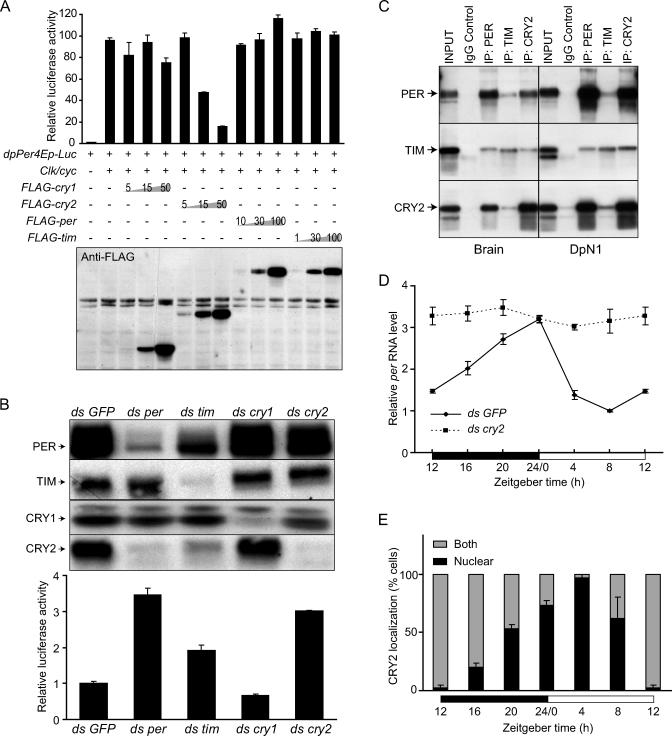
CRY2 Is a Major Repressor of CLK:CYC–Mediated Transcription in DpN1 Cells(A) Monarch CRY2 inhibits dpCLK:dpCYC–mediated transcription using luciferase reporter gene assays. The monarch butterfly per E box enhancer luciferase reporter (dpPer4Ep-Luc; 50 ng) was used in the presence (+) or absence (–) of monarch CLK/CYC expression plasmids (50 ng each). Monarch cry1 (5, 15, and 50 ng), cry2 (5, 15, and 50 ng), per (10, 30, and 100 ng), or tim (1, 30, and 100 ng) was used. Luciferase activity relative to β-galactosidase activity was computed. Each value is the mean ± SEM of three independent transfections. Western blot of FLAG-epitope–-tagged protein expression levels for each concentration of each construct is depicted below the graph.(B) De-repression assay showing that endogenous CRY2 inhibits dpCLK:dpCYC–mediated transcription. The monarch per E box luciferase reporter and monarch CLOCK and CYC were co-transfected into DpN1 cells to elevate reporter activity. The ability of endogenous PER, TIM, CRY1, or CRY2 to inhibit CLK:CYC-mediated transcriptional activity was then evaluated using dsRNA directed against each RNA to determine what effect knockdown had on the levels of all four clock proteins (Western blots using PER-GP40, TIM-GP47, CRY1-GP37, or CRY2-GP51, upper panel) and whether knockdown elevated (de-repressed) luciferase activity (lower panel). The luciferase values are the mean ± SEM of three independent experiments.(C) Monarch clock proteins form multimeric complexes in vivo. Brain or DpN1 extracts from ZT 18–19 were immunoprecipitated with antibodies against monarch PER (R33), TIM (R38), or CRY2 (R41). Immunocomplexes generated by each antibody were then analyzed by Western blot and probed for all three proteins (PER-GP40, TIM-GP47, and CRY2-GP51).(D) Knockdown of endogenous CRY2 abolishes the diurnal per RNA rhythm. dsRNA against monarch cry2 was transfected into DpN1 cells to knock down CRY2 (Figure S9A), and per RNA levels were monitored at 4-h intervals over 24 h in LD. Double-stranded RNA against GFP served as the control. Relative monarch per RNA levels are depicted. Each value is mean ± SEM of three experiments. Solid line, GFP control; dashed line, CRY2 knockdown.(E) Oscillation in nuclear CRY2 abundance in DpN1 cells. Cells were entrained to LD and then fixed at 4-h intervals over 24 h in LD. The cellular localization of CRY2 was assayed by immunocytochemistry using CRY2-GP51. The cells were counterstained with SYTOX Blue to visualize the nuclei. At each time point, the localization of CRY2 in the cells was categorized as nuclear, cytoplasmic, or both nuclear and cytoplasmic. The proportion of cells at each time point in each category was calculated as the percentage of the total number of cells counted (30 per slide). Each bar represents the mean ± SEM of three experiments. Representative photomicrographs of CRY2 staining in nucleus, and in both cytoplasm and nucleus are shown in Figure S9B.